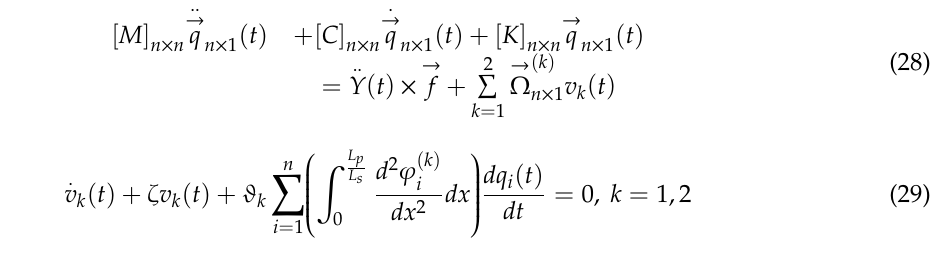
Table 3. Physical and geometrical properties of the piezoelectric materials. Parameter Symbol Unit Value Width of the piezoelectric layers b p mm 7 Young’s modulus of the piezoelectric layer E p GPa 66 Permittivity ε s nF / m 15.93 33 Piezoelectric constant d 31 pm / v − 190 Mass density of the piezoelectric layer ρ p kg / m 3 7800 Electrical resistance R l M Ω 0.2 Thickness of the piezoelectric layers h p mm